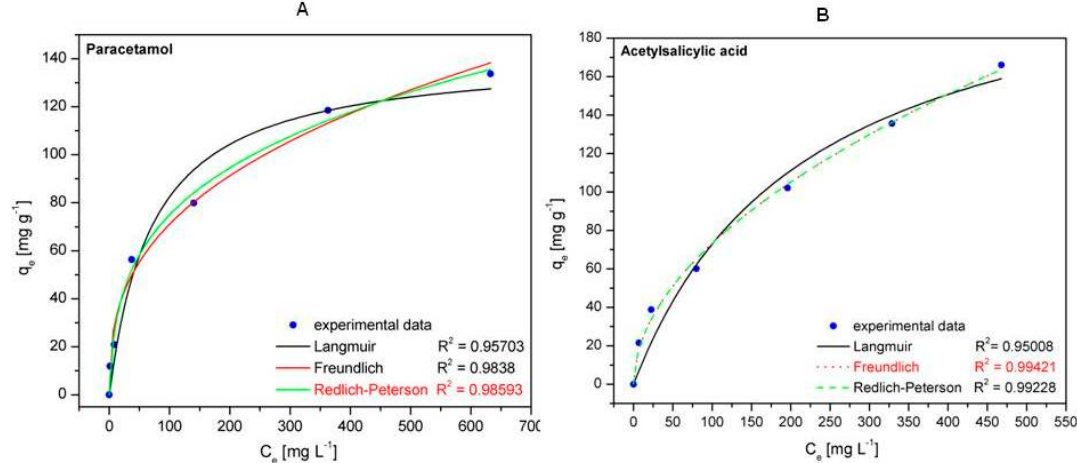
Figure 11. Isotherm plots for paracetamol ( A ) and acetylsalicylic acid ( B ) on the Fe 3 O 4 @C